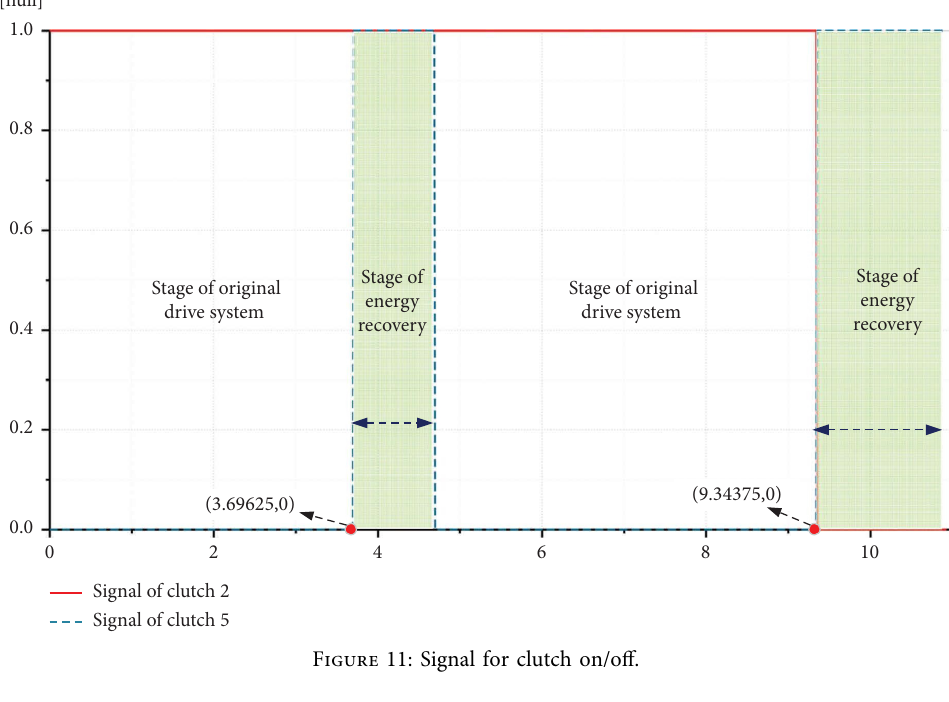
Figure 11: Signal for clutch on/of.